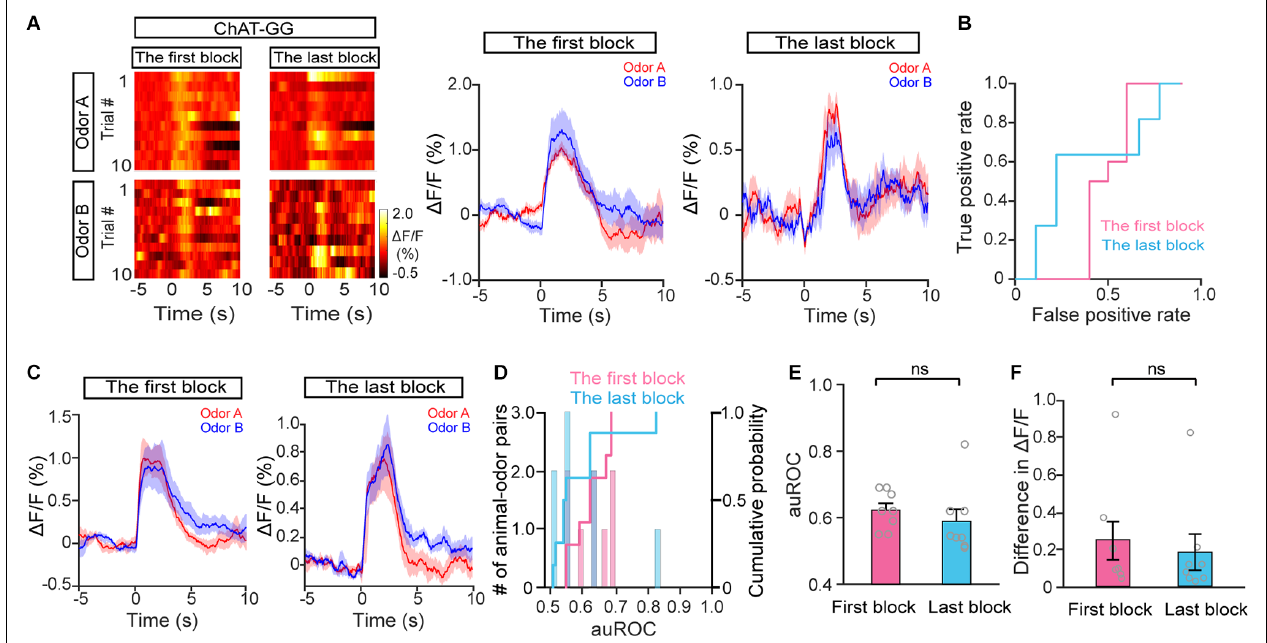
FIGURE 5 | The response profiles of HDB cholinergic neurons in Odor A trials and Odor B trials during the go/go task. (A) Representative heat maps and corresponding traces of cholinergic responses in Odor A and Odor B trials in the first block and the last block during the go/go task. (B) ROC graph for the Odor A and Odor B responses in the first block and the last block shown in (A) . (C) Averaged traces of cholinergic responses in Odor A and Odor B trials in the first block and the last block across all animal–odor pairs ( n = 16 animal–odor pairs from eight mice). (D) Histograms and cumulative probability of auROCs in the first block and the last block. (E and F) Comparison of auROCs (E) and difference in ∆ F/F (F) in the first block and the last block [ (E) Wilcoxon signed-rank test, z = 1.40, P = 0.16 (F) paired t -test, t (7) = 0.53, P = 0.61]. ns, no